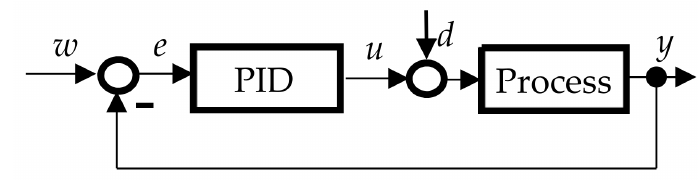
Figure 23. Closed loop